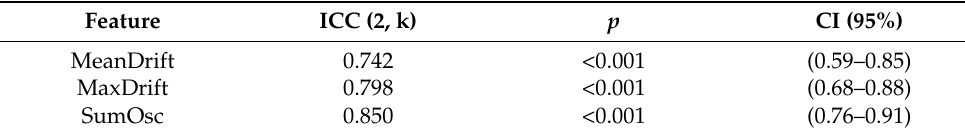
Table 2. Intra-class correlation coefficients (ICCs) of kinematic features (2-way